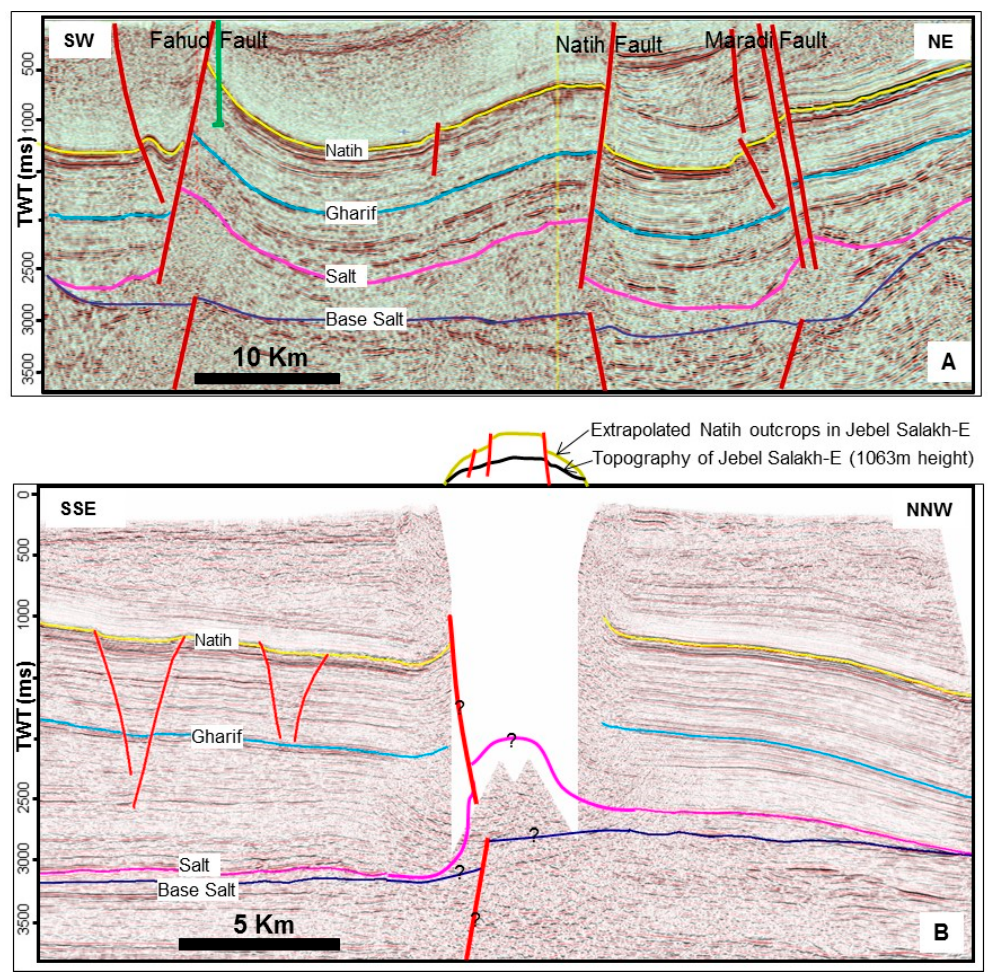
Figure 22. A comparison between the structures that developed in the Fahud Salt Basin. ( A ) Fahud, Natih and the Maradi Fault System. These three structures are underlain by thick salt bodies that most likely localized above basement faults or steps. ( B ) The Salakh E structure uses a seismic line that was acquired on both sides of the Jebel, hence, a simple surface cross-section is constructed to compare it with subsurface reflections. The locations of these seismic lines are shown in Figure 1.